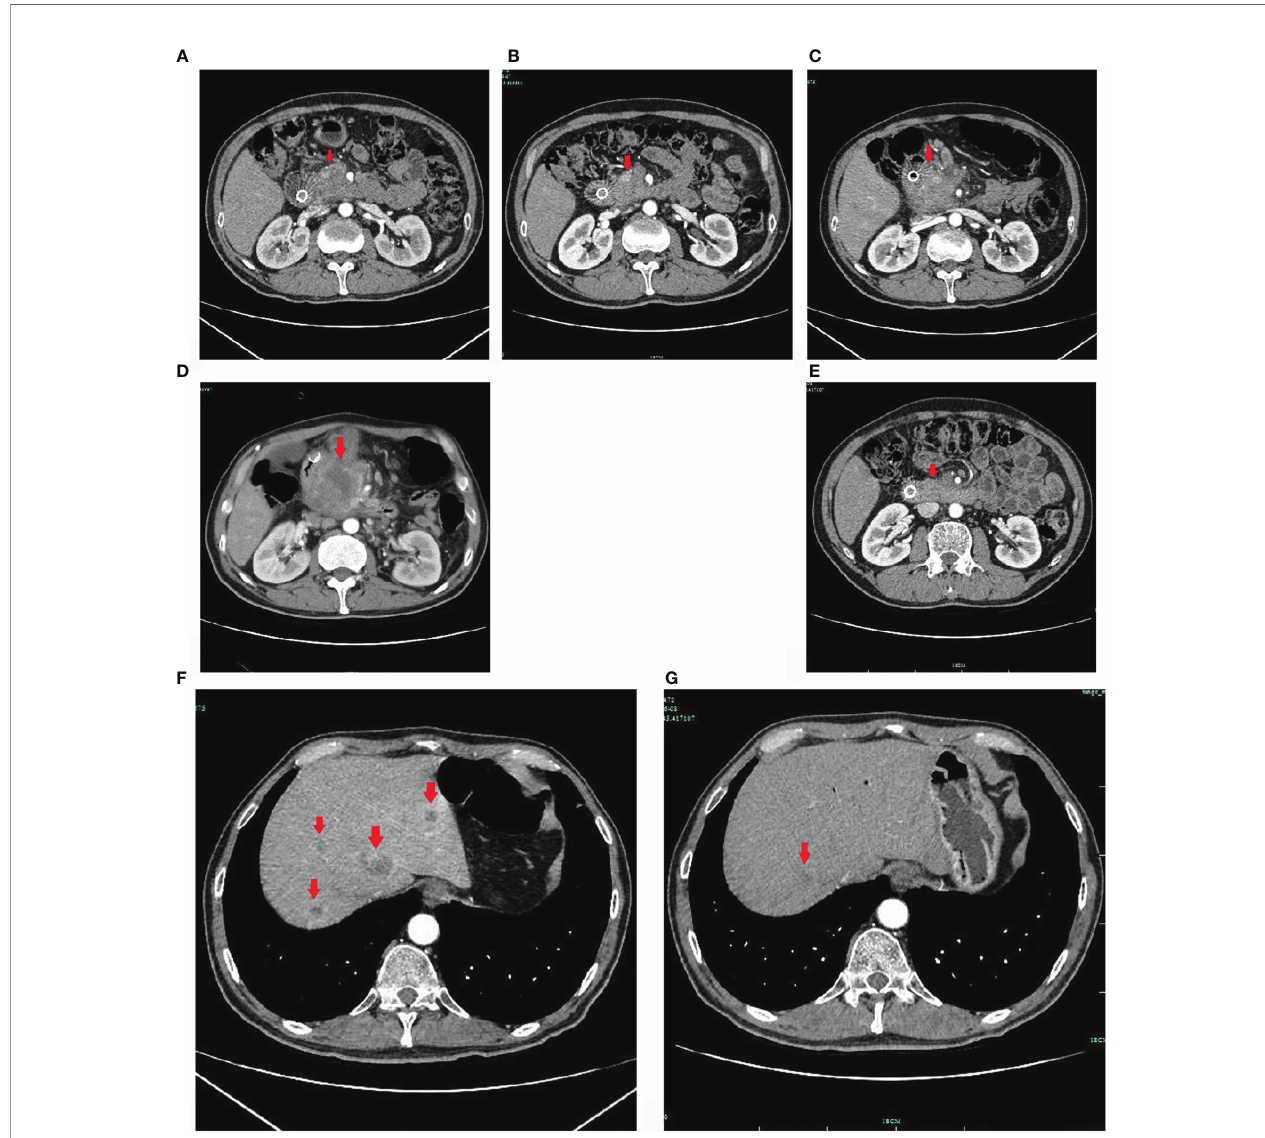
FIGURE 2 | Enhanced CT images. The pancreatic mass indicated by the arrow on upper-abdomen enhanced CT took in June 2020 (A) , in August 2020 (B) , in October 2020 (C) and in November 2020 (D) . The pancreatic cancer was responded to chemotherapy initially, but the disease was still progressed at later time. After sintilimab combined with S-1 treatment, the pancreatic lesion was signi fi cantly reduced in, and nearly disappeared in June 2021 (E) . The hepatic metastases indicated by the arrows on upper-abdomen enhanced CT took in October 2020 (F) , and in June 2021 (G) . The hepatic metastasis was signi fi cantly reduced (G)